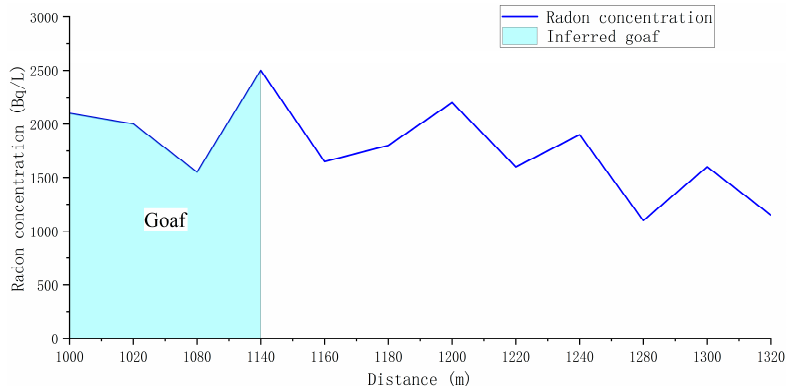
Figure 11. Profile Map of Radon Measurement by Activated Carbon for Survey Line L2.